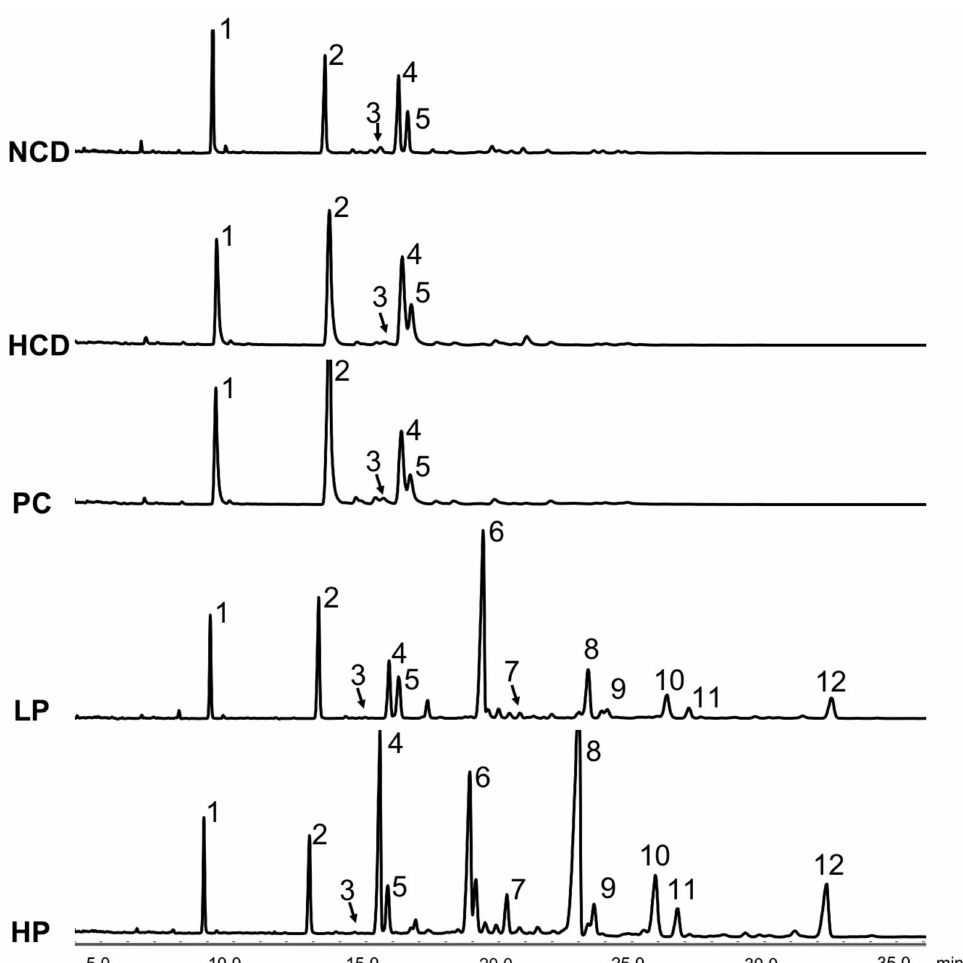
Figure 7. Gas chromatogram of fecal neutral sterols and phytosterols at week 6 in hamsters fed one of five diets: NCD, no cholesterol diet; HCD, high cholesterol diet containing 0.1% cholesterol; PC, high cholesterol diet containing 0.5% cholestyramine; LP, high cholesterol diet containing a low dose (0.1%) soybean germ phytosterols (SGP); HP, high cholesterol diet containing a high dose (0.2%) of soybean germ phytosterols (SGP). Peaks: 1, 5 α -cholestane (internal standard); 2, coprostanol; 3, coprostanone; 4, cholesterol; 5, dihydrocholesterol; 6, campesterol; 7, stigmasterol; 8, β -sitosterol; 9, stigmastanol; 10, ∆ 7-stigmastenol; 11, ∆ 7-avenasterol; 12,